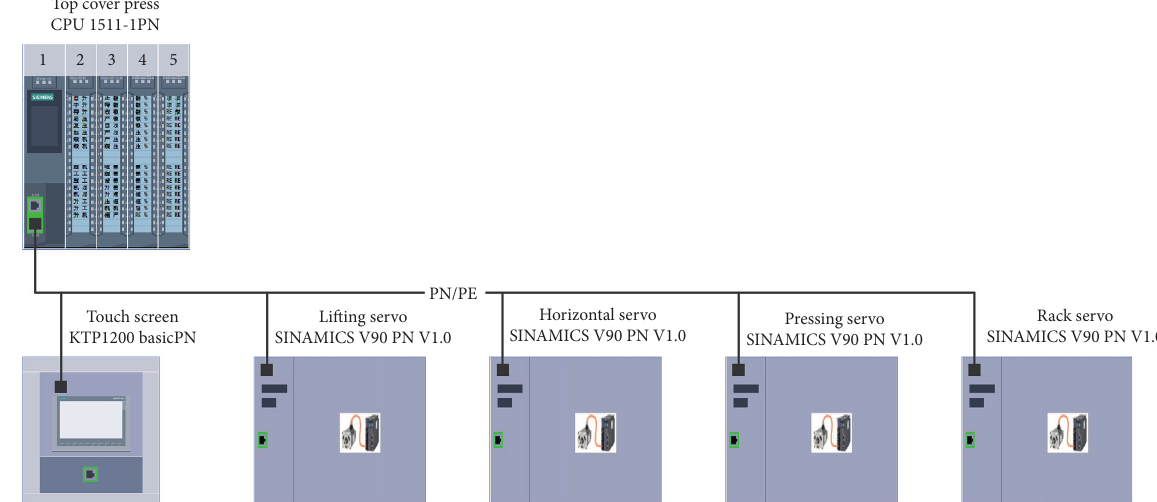
Figure 14: The equipment configuration network diagram of the control system of the water heater tank capping